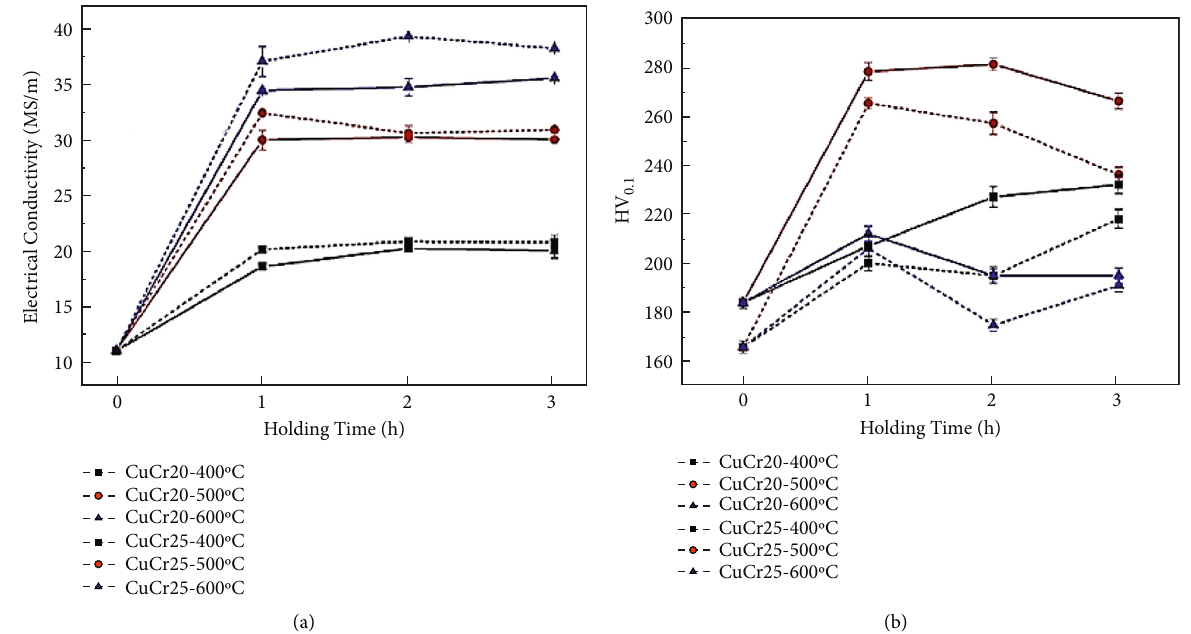
Figure 15: Properties of SLM CuCr20 and CuCr25 aged under different conditions: (a) electrical conductivity and (b) hardness